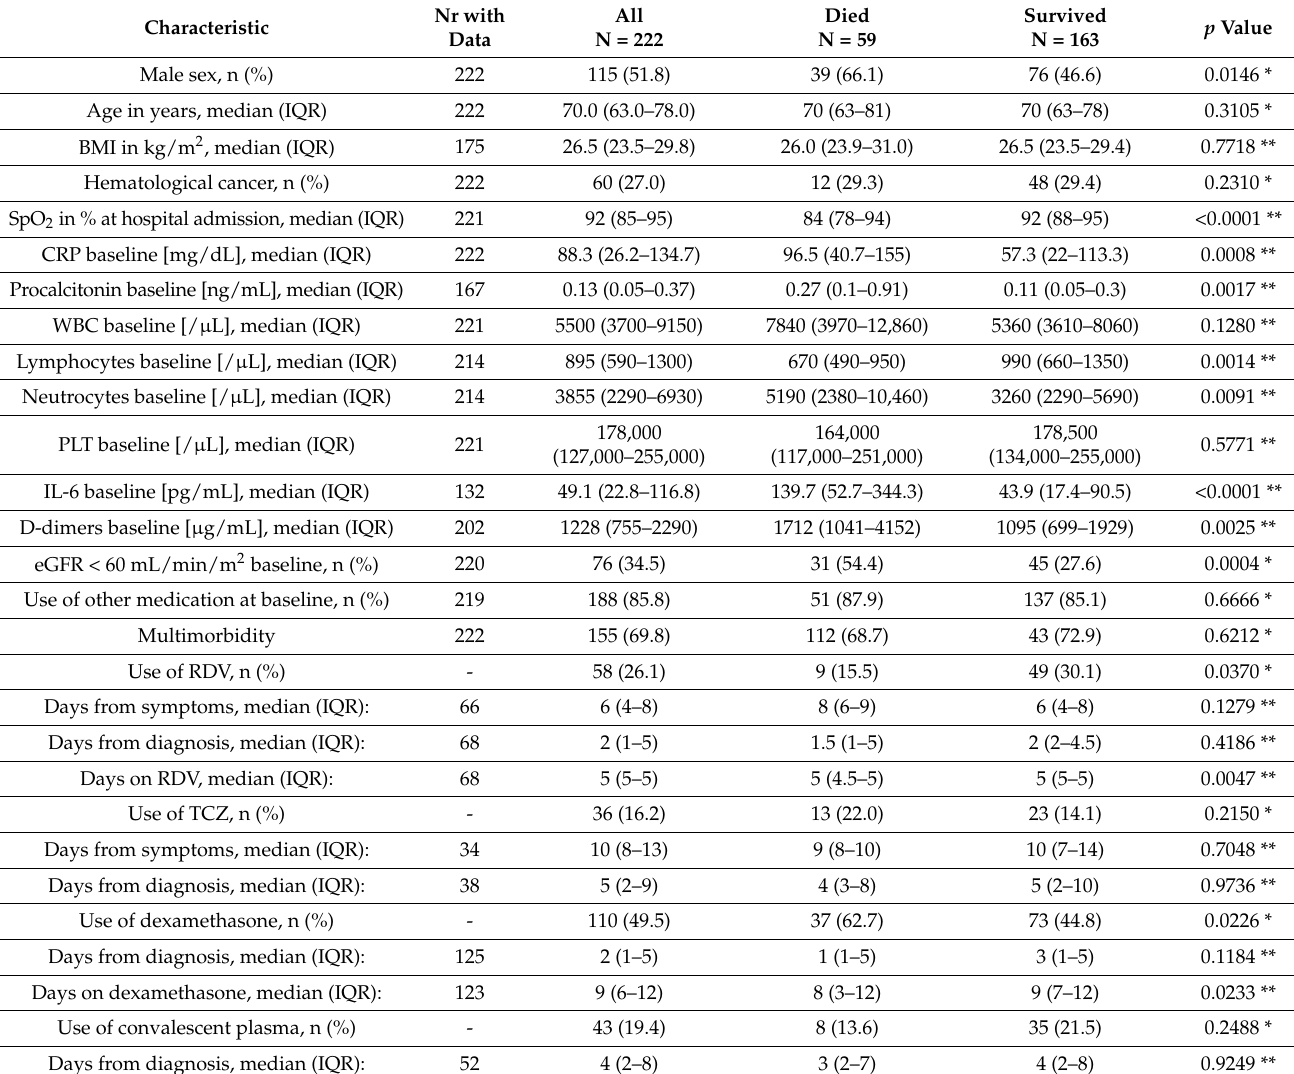
Table 1. In terms of disease severity 25% of patients had SpO 2 below 85% (median 92% IQR: 85–95%). In terms of disease progression, 59 (26.6%) of patients died before or on day 28 of hospitalization, 47 (29%) in the group with hematological cancer, and 12 (20%) in the group with other cancers ( p = 0.231). Table 1. Baseline characteristics of studied cohort stratified by early hospital